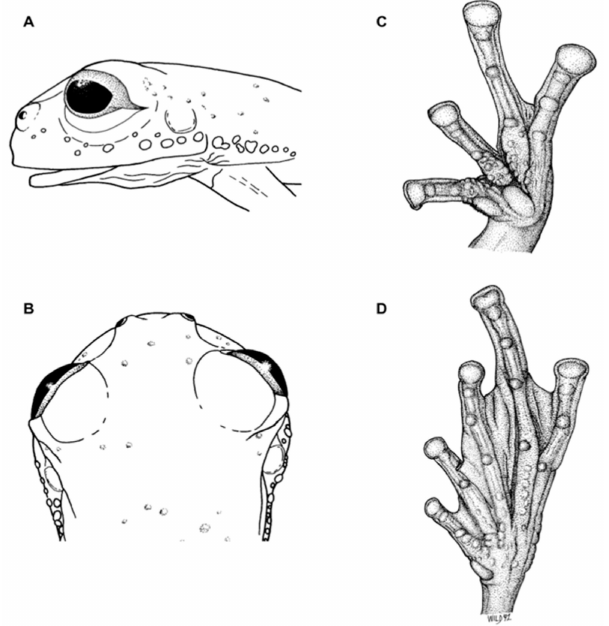
Figure 57. Centrolene sanchezi in life. ( A , B ) Male and female from Yanayacu Biological Station, Ecuador. ( C ) Holotype of C . sanchezi , ICN 24293. ( D ) Paratype of C . guanacarum , ICN 11685. Photos by A. Arteaga ( A , B ) and P. Ruiz-Carranza ( C , D ).